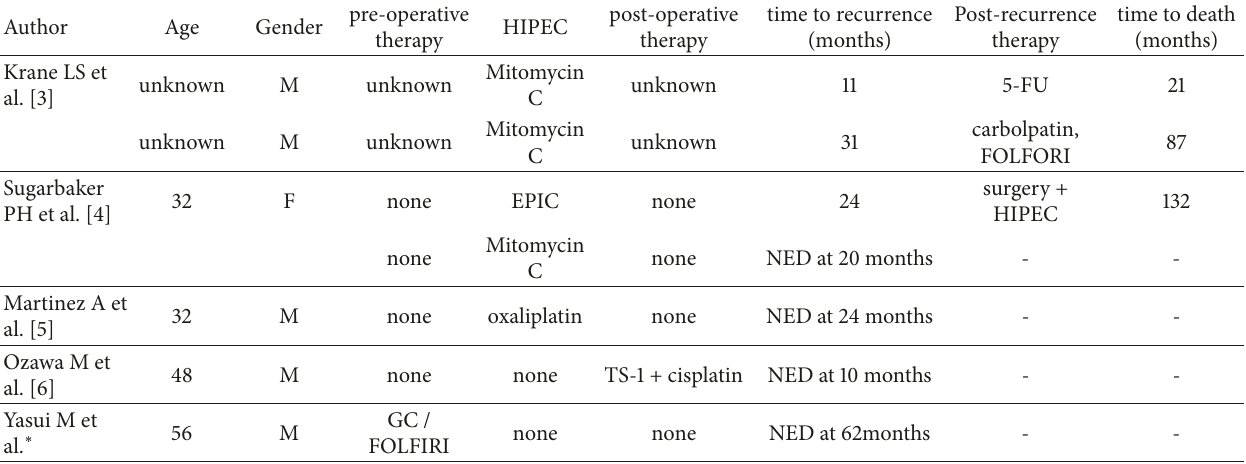
Table 1: Previous reports of urachal adenocarcinoma with peritoneal dissemination treated with cytoreductive surgery.